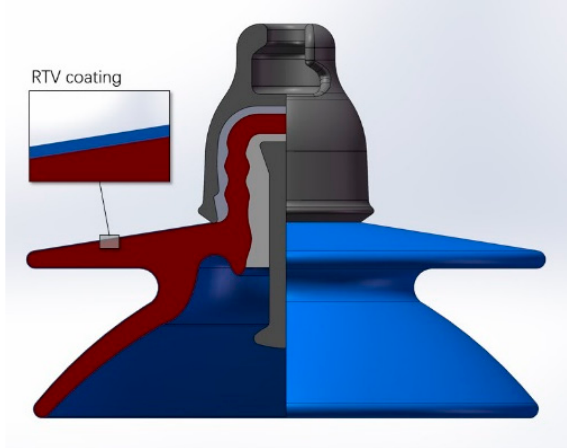
Figure 2. FXWP2-70 insulator.